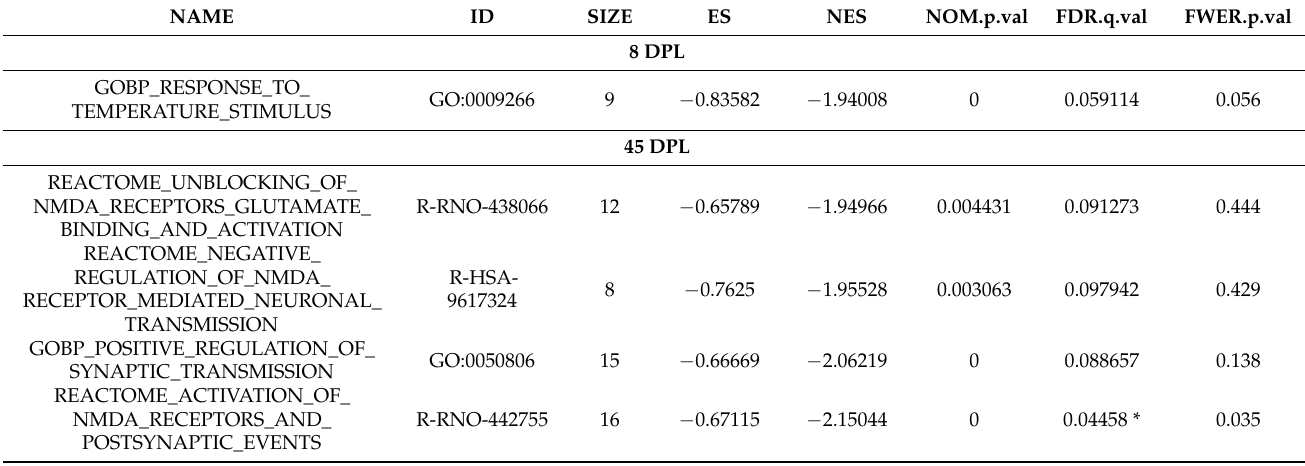
Table 5. Early (8 DPL peak) and late (45 DPL peak) profiles deregulated pathways in the